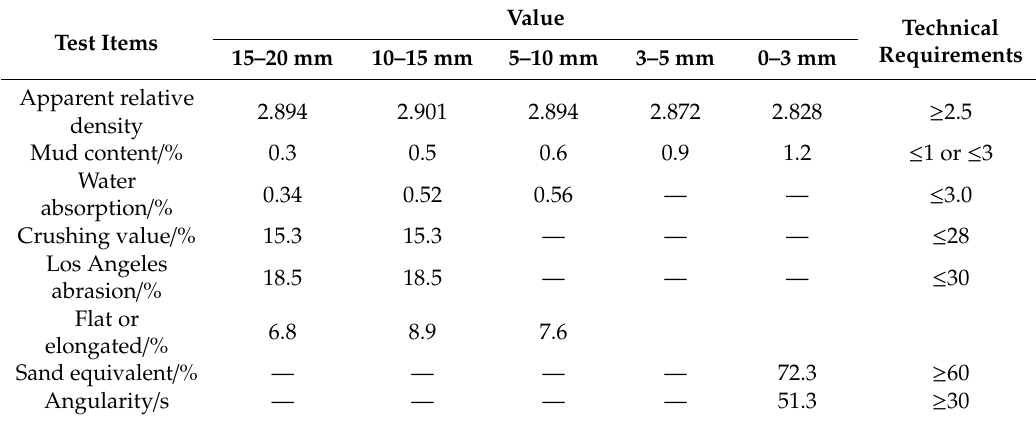
Table 3. Physical Properties of Aggregates.